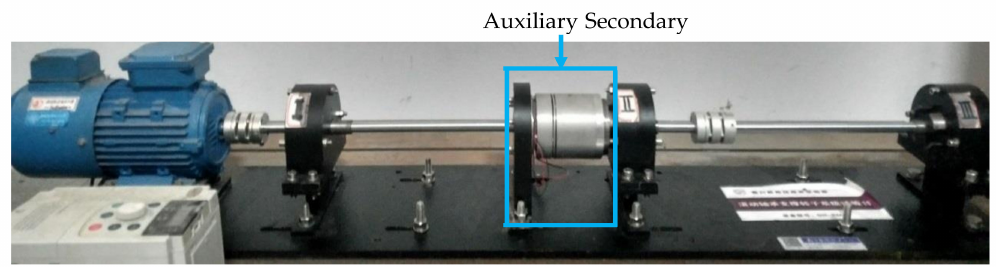
Figure 16. Three-support shafting test bench with Smart Spring pair support.